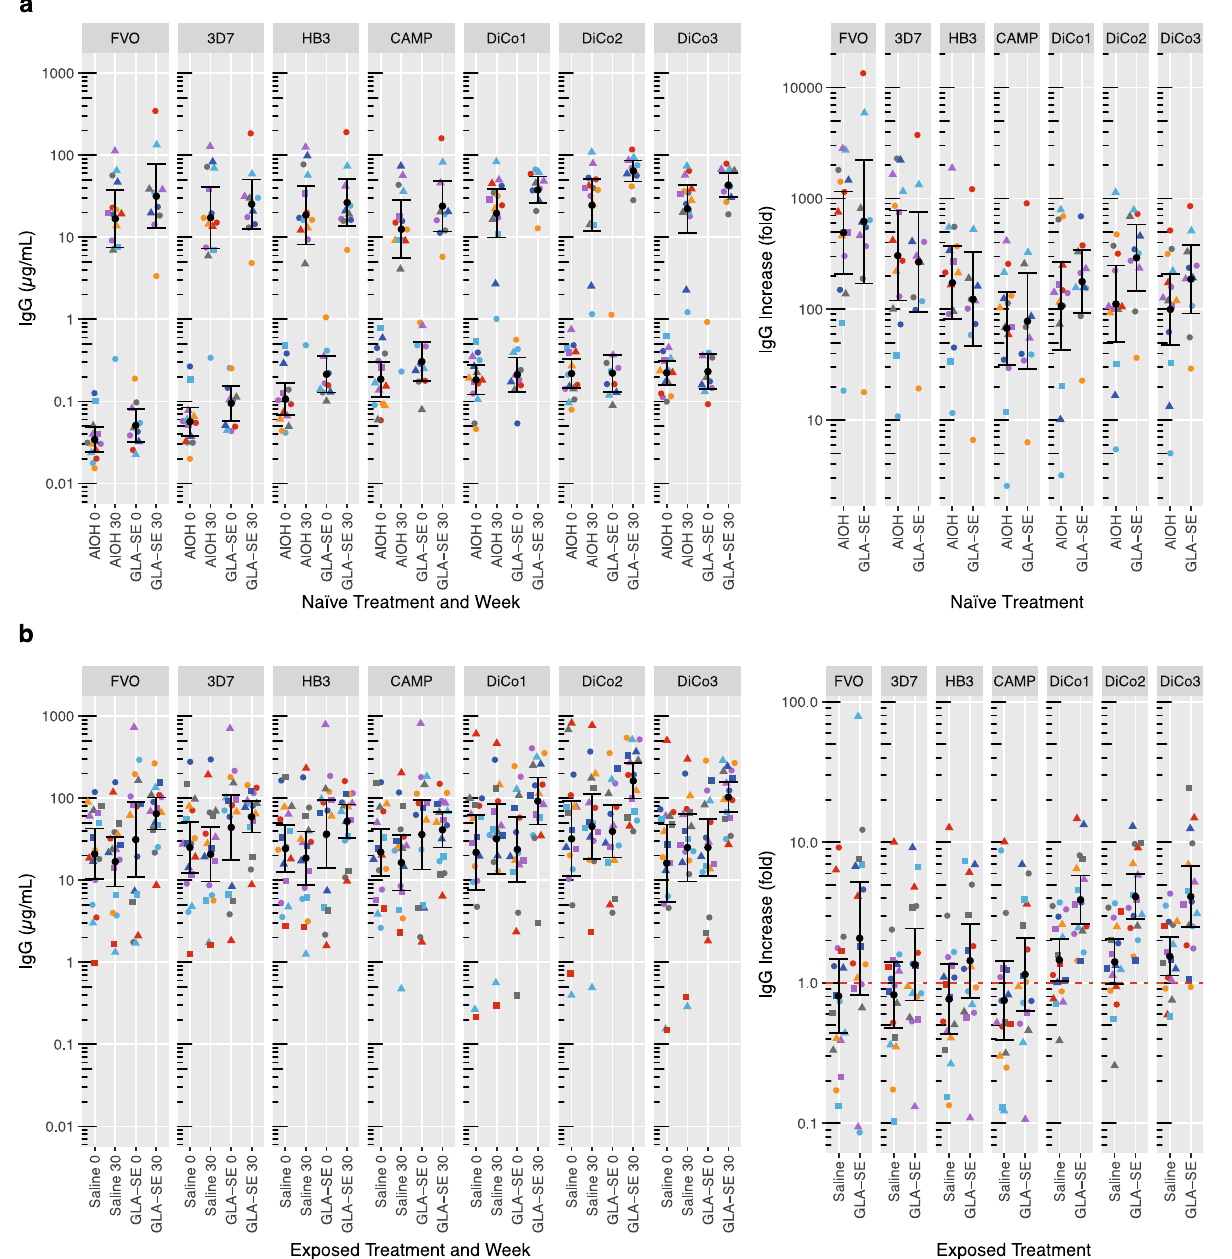
Fig. 1 IgG levels to 4 natural AMA1 variants and the DiCo variants before and 4 weeks after the third vaccination. a Malaria-naive and b malaria-exposed adults. Individual IgG levels before and four weeks after the third vaccination and IgG level ratios between week 30 and week 0 are shown together with the IgG fold-increase. Colours and shapes within treatment groups indicate individual subjects. Summary statistics (geometric means with 95% con fi dence intervals) are shown in every panel. The red dashed line in the IgG increase indicates no change in IgG (ratio post/pre-vaccination = right-hand panel). Titre rises for FVO were signi fi cantly higher than malaria-naive adults to four natural AMA1 variants and the DiCo those for DiCo1, DiCo3, HB3 and CAMP (4.1 [13 to 13.3], p = 0.009, variants at week zero and four weeks after the third vaccination 4.2 [1.3 to 13.6], p = 0.007, 3.6 [1.1 to 11.7], p = 0.025 and 7.6-fold (Fig. 1a). The number of amino acid differences between the seven [2.3 to 24.6], p < 0.00001, respectively). Titre rises for CAMP were AMA1 variants is shown in supplementary table 1. Before signi fi cantly lower than those for 3D7 (0.25-fold [0.08 to 0.81], vaccination IgG levels ranging from 0.1 to 0.3 µg/mL were p = 0.01). IgG level rises tended to be higher for the 3 DiCo observed for the three DiCo, HB3 and CAMP variants, whereas vaccine variants (twofold, 0.71 to 5.7) in the GLA-SE as compared pre-vaccination levels for the FVO and 3D7 variants were to the Alhydrogel ® group ( p = 0.17, LMM), while by contrast rises signi fi cantly lower (0.04 and 0.07 µg/mL, respectively (all for the 4 natural variants did not differ for the treatment groups p < 0.013 Tukey HSD)). Four weeks after the third vaccination (0.98-fold (0.29 to 3.3), p = 0.98, LMM). The anti-AMA1 IgG levels IgG level rises ranging between 67 (CAMP Alhydrogel ® ) and 618- observed four weeks following the third vaccination ranged fold (FVO GLA-SE) were observed for the 7 AMA1 variants (Fig. 1a